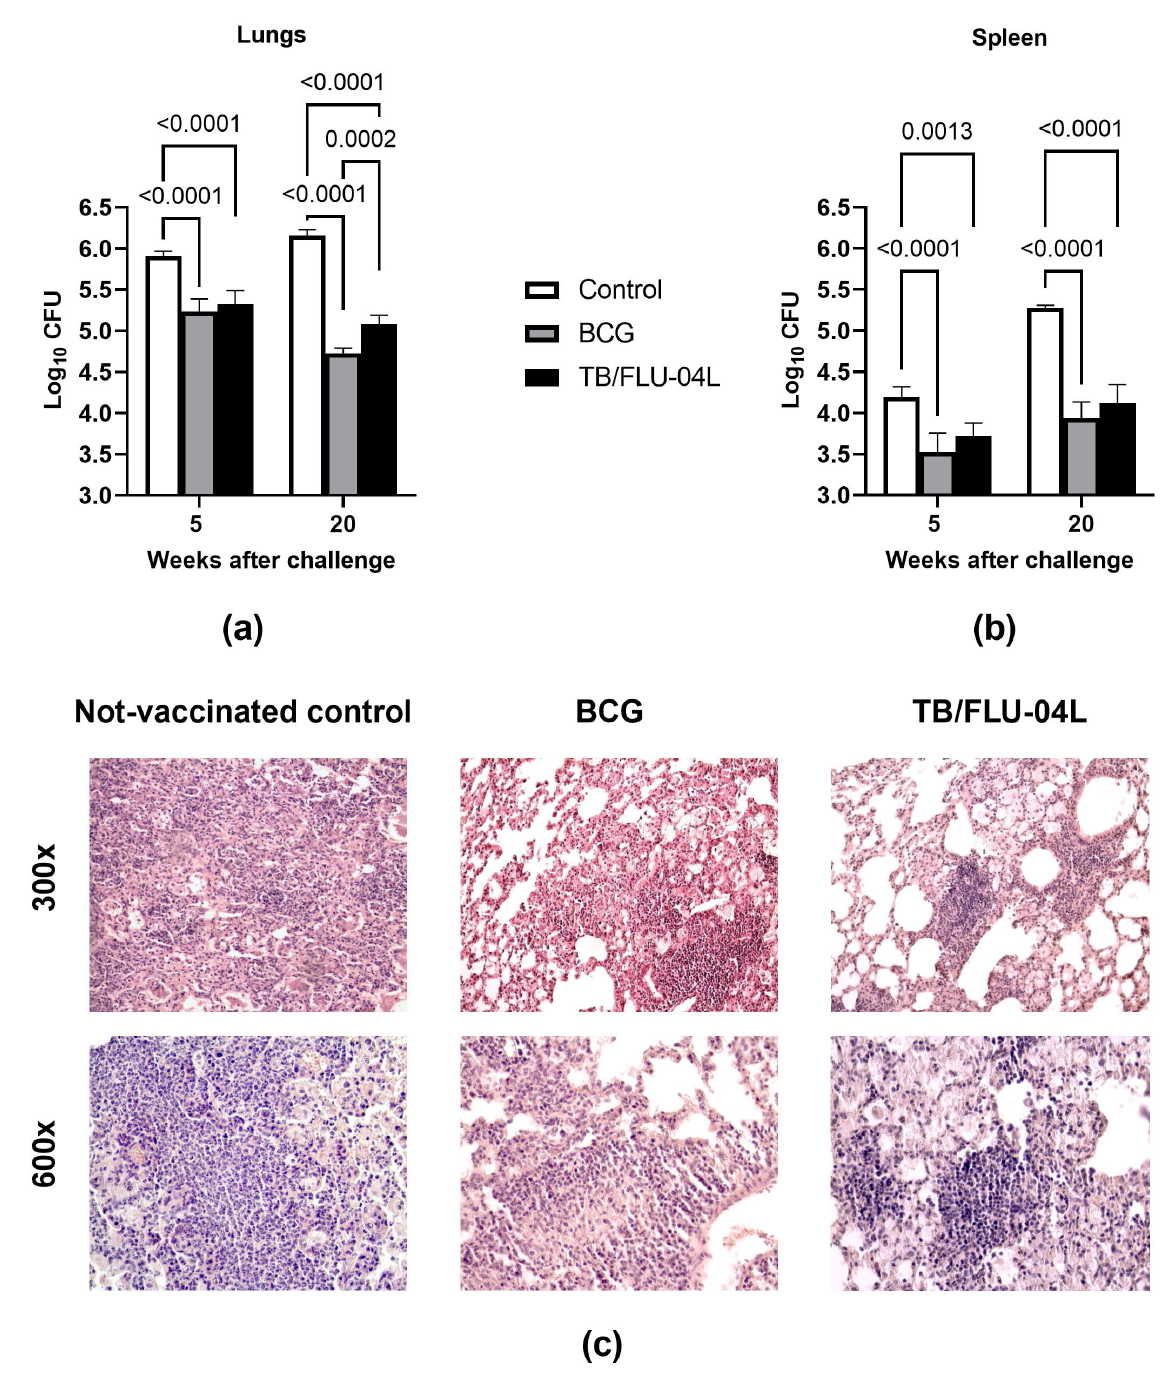
Figure 5. Protective immunity against virulent M. tuberculosis intravenous challenge in mice following intranasal vaccination with TB/FLU-04L. C57BL/6 mice received saline i.n. (naive), or 1 × 10 5 BCG s.c., or TB/FLU-04L i.n. twice with three-week intervals. Three weeks after the second vaccination, mice were challenged by an i.v. injection of 10 6 CFU of virulent M. tuberculosis Erdman strain.